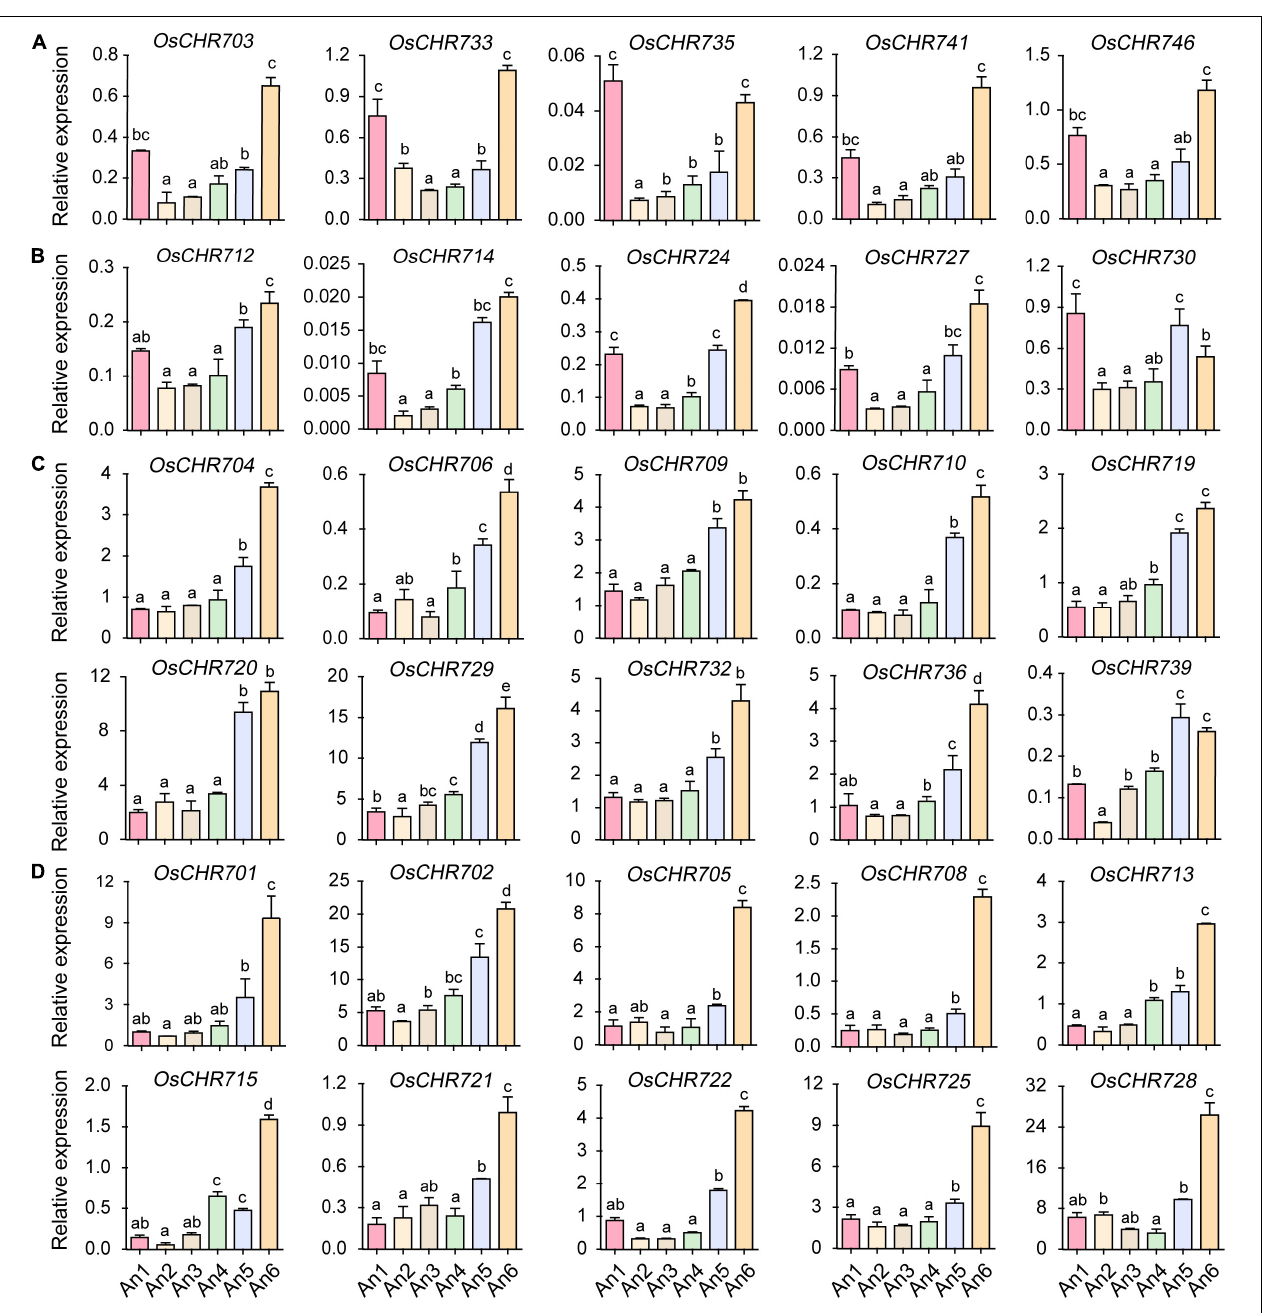
FIGURE 2 | The relative expression level of Snf2 gene family in the stamen. (A) Predominately expressed Snf2 genes at the An1 and An6 stages. (B) Preferentially expressed Snf2 genes at the An1, An5, and An6 stages. (C) Preferentially expressed Snf2 genes at the An5 and An6 stages. (D) Predominately expressed Snf2 genes at the An6 stages. An1-5, the stamen of 2–3, 3–4, 4–5, 5–6, and 6–7 mm spikelet, respectively; An6, the stamen in the spikelet before flowering. The y -axis is the relative expression level of the gene compared to OsUBQ5 in different developmental stages of stamen using the qRT-PCR. The relative expression level of OsCHR701 to OsUBQ5 in An1 stage normalized as “1” was used as reference. Error bars indicate standard deviations of independent biological replicates ( n = 3). Different letters denote significant difference at P < 0.05 according to ANOVA in combination with Duncan’s multiple range